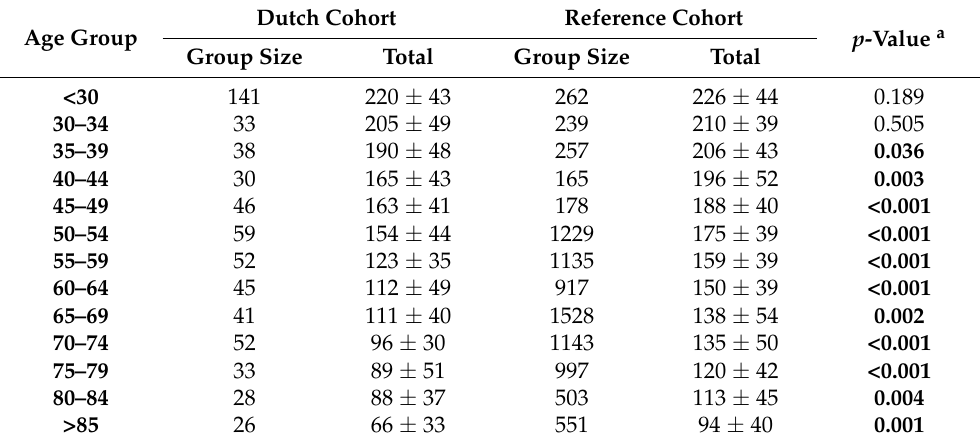
Table 3. Bone mineral density (mean HU ± SD) by age group in the Dutch cohort and the North American reference cohort [13].